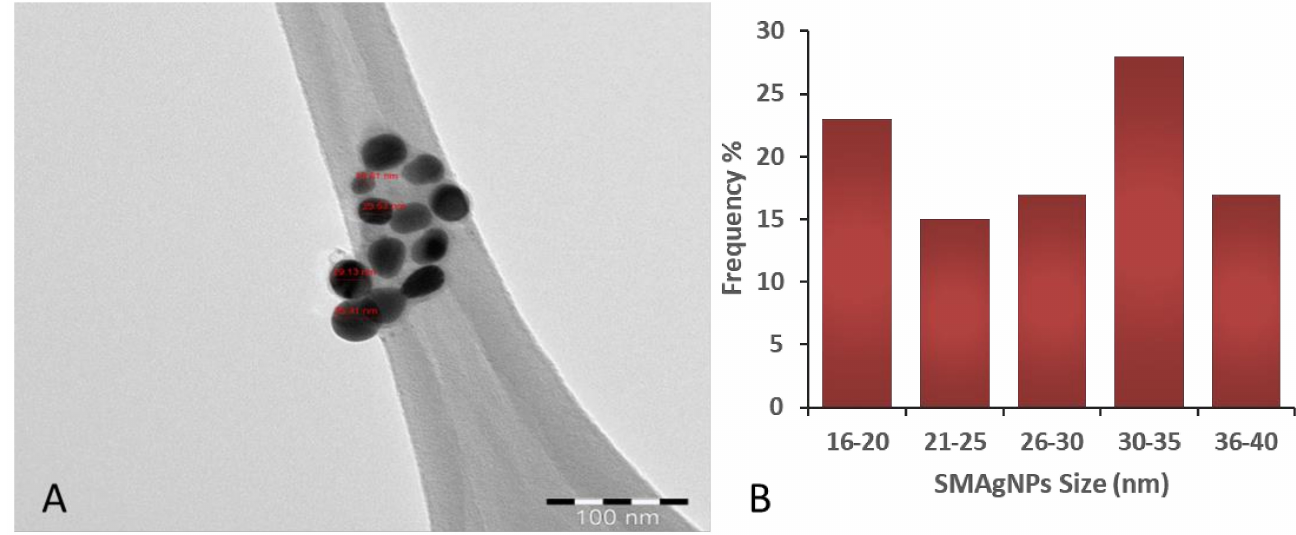
Figure 2. The transmission electron microscopy micrograph of the biosynthesized SMAgNPs ( A ) shows the spherical shape, with size distribution ranging from 16.5–38.5 nm. Quantitative analysis of more than 100 SMAgNPs revealed the frequency at which the NPs were found to be in the above range ( B ).